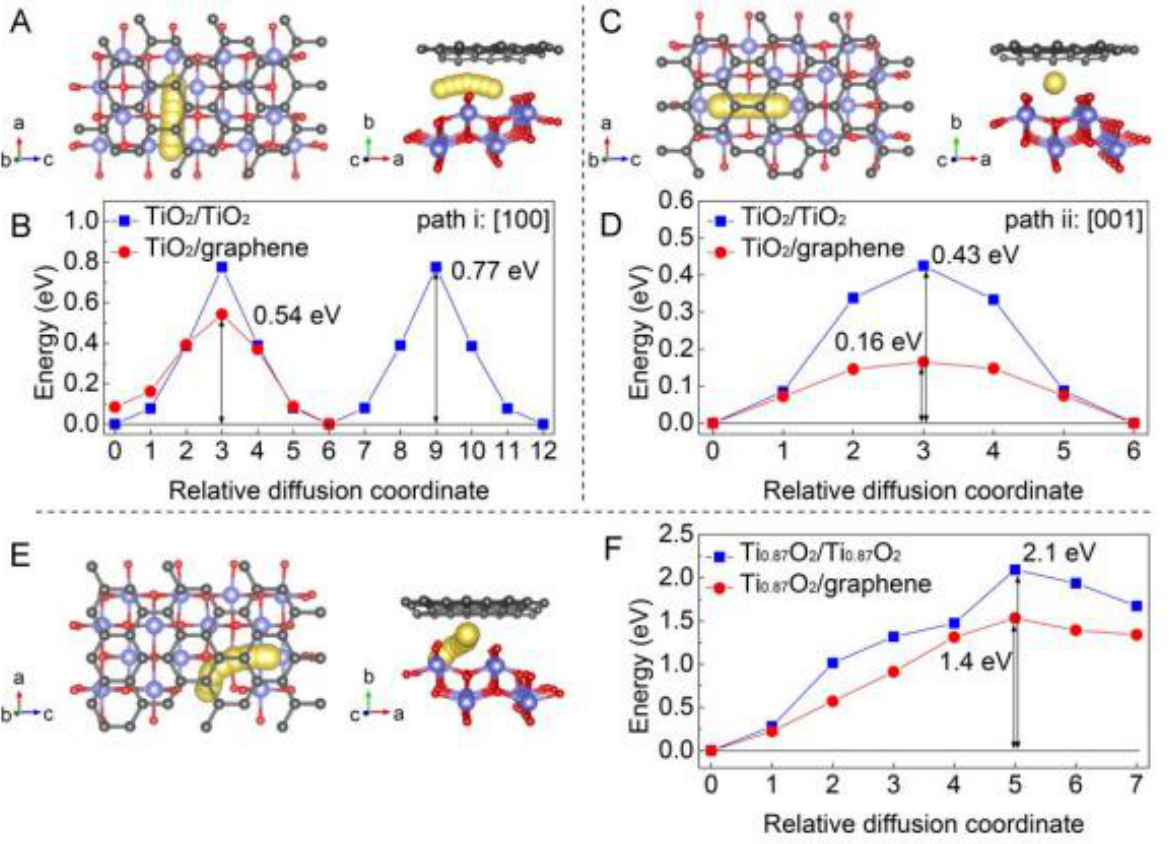
Figure 8. ( A ) Diagram of the sodium diffusion path towards the [100] directions between the TiO 2 /graphene bilayers. ( B ) The energy of sodium diffusion along the [100] direction in TiO 2 bilayers and TiO 2 /graphene bilayers. ( C ) Illustration of the Na diffusion path along the [001] directions between the TiO 2 /graphene bilayers. ( D ) The energy of Na diffusion along the [001] direction in TiO 2 bilayers and TiO 2 /graphene bilayers. ( E ) Illustration of a possible Na diffusion path in Ti 0.87 O 2 /graphene bilayers. ( F ) The energy of Na diffusion in Ti 0.87 O 2 bilayers and Ti 0.87 O 2 /graphene bilayers. Reprinted with permission from [41]. Copyright 2018 American Chemical Society .